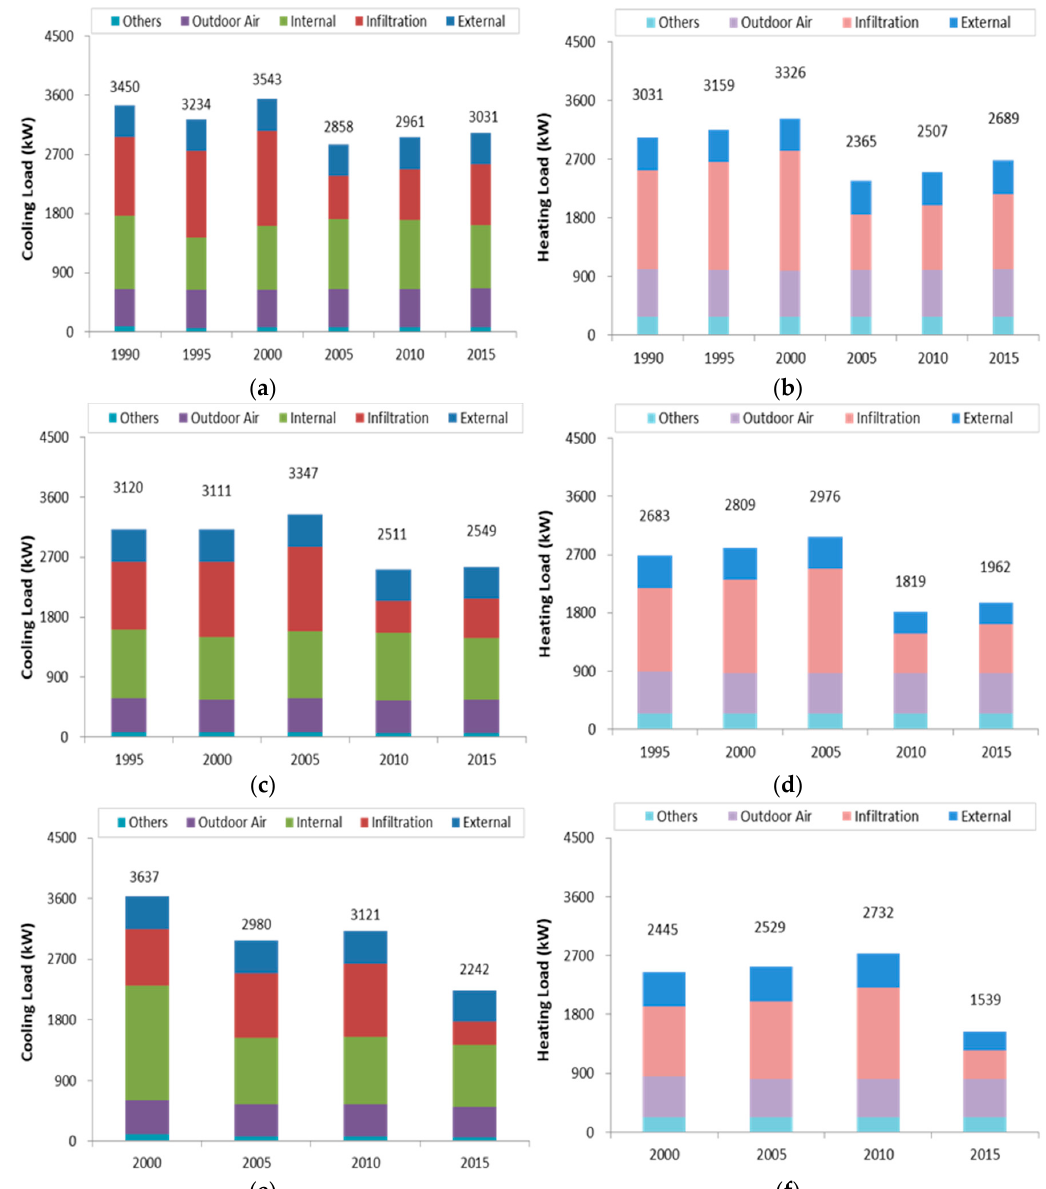
Figure 10. The result of the max. cooling and heating loads for Scenario II through IV: ( a ) The result of the max. cooling load calculation for Scenario II; ( b ) Result of the max. heating load calculated for Scenario II; ( c ) Result of the calculation for the max. cooling load for Scenario III; ( d ) The result of the calculation of max. heating load for Scenario III; ( e ) The result of the max. cooling load calculation for Scenario IV;( f ) Result of the max. heating load calculated for Scenario IV.